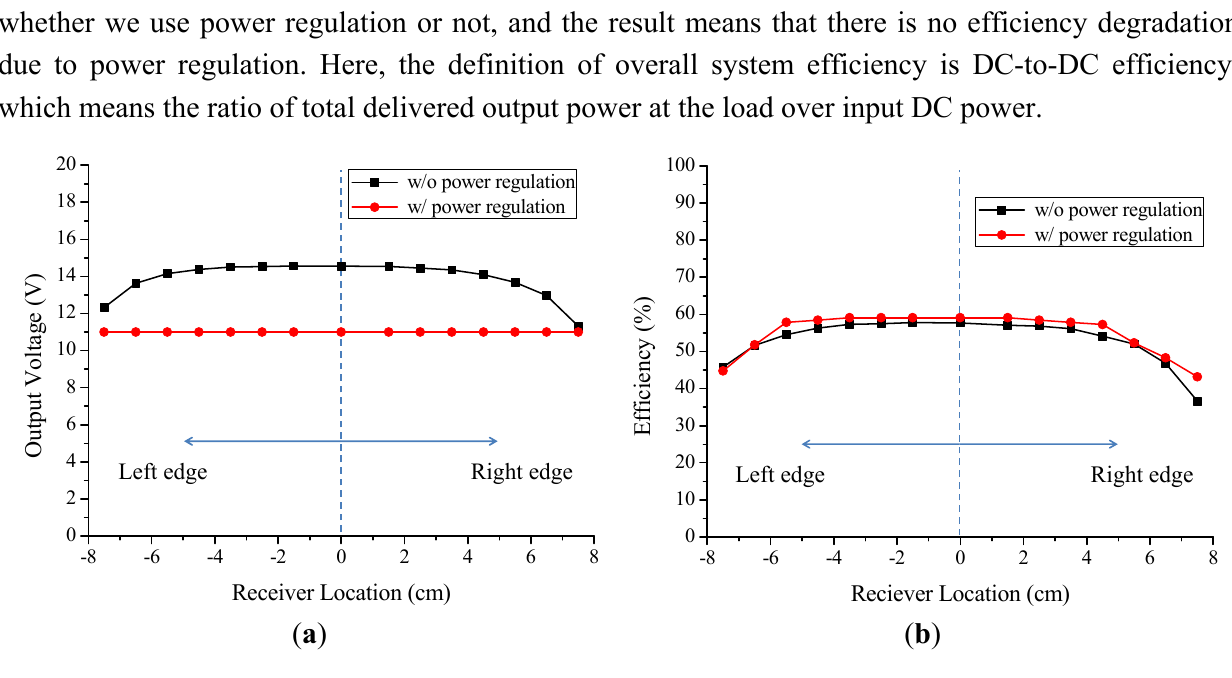
Figure 11. Measured result of output voltage for different receiver positions. ( a ) Output voltage. ( b )